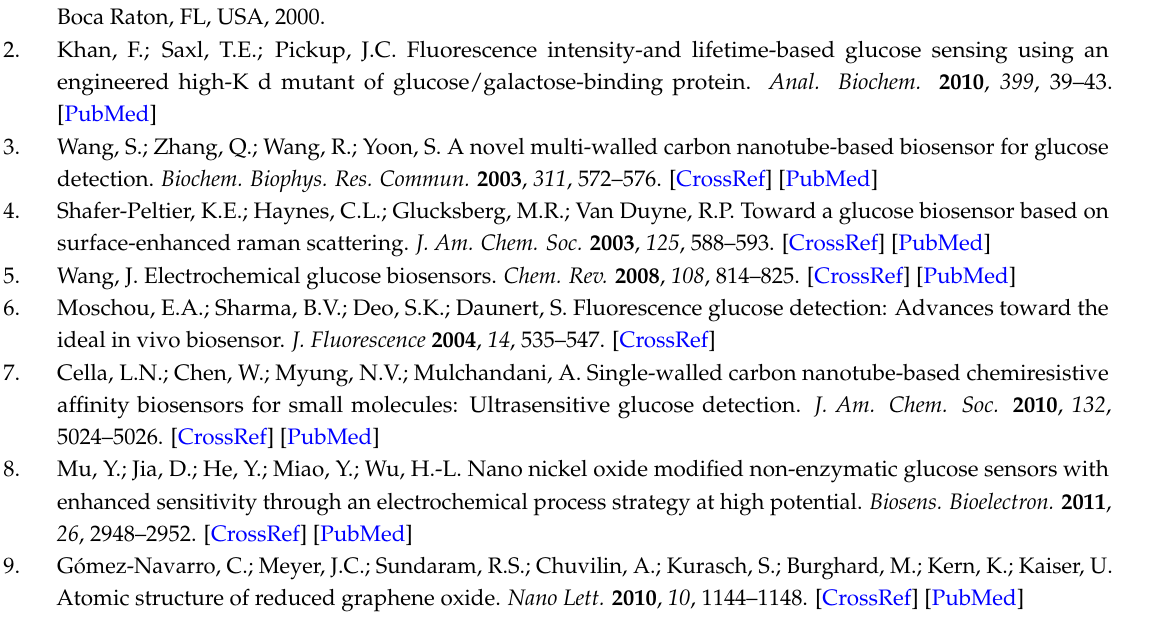
Figure S1: S-parameter results, (a) S11; (b) S21, of several electrodes with open without interconnector, GO, RGO,